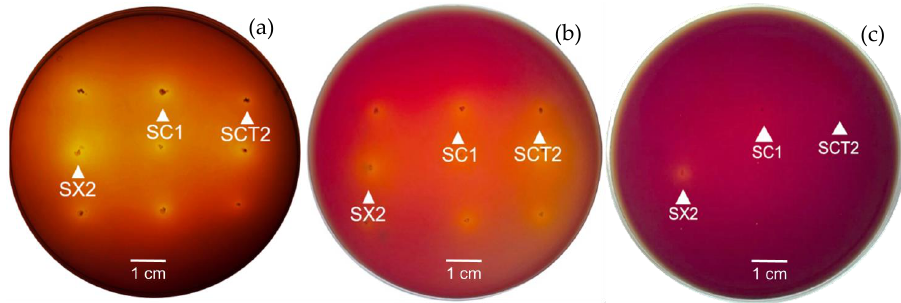
Figure 3. Growth and clear zone formation of xylose-utilizing LAB, E. faecalis SC1, E. faecalis SCT2, and E. hirae SX2, on MRS-xylose agar ( a ), MRS-xylose agar supplemented with 1 g/L tannin ( b ), and 5 g/L tannin ( c ), when cultivated at 37 °C for 24 h. Table 1. Antimicrobial activity of LAB isolates against some pathogenic